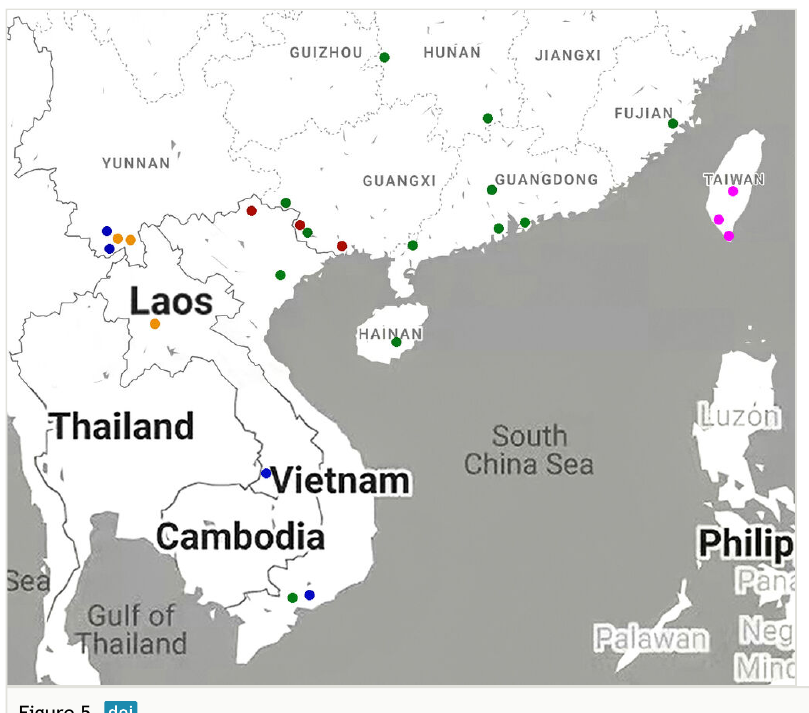
Figure 5. Distribution map for Pareuryaptus spp. known from China: P. adoxus (Tschitschérine) (blue); P. exiguus Dubault, Lassalle & Roux (red); P. luangphabangensis Kirschenhofer (orange); P. chalceolus chalceolus (Bates) (green); P. chalceolus formosanus (Jedli č ka)